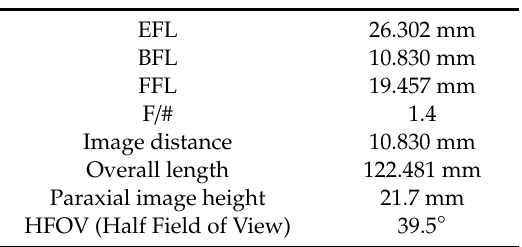
Figure 3. Optical layout for KR20140124286AP, Example 1. Table 1. First orders of optical layout after combining the optical layout of JP20160012034A2P and the optical layout of KR1020140124286AP.